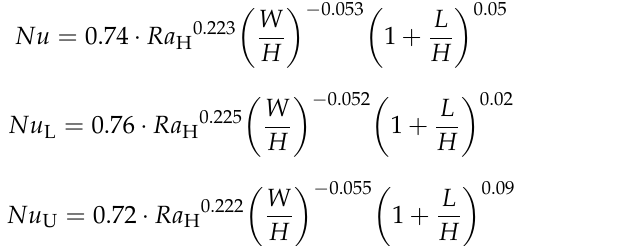
Figure 14. Comparison between Equation (9) and the numerical data obtained for Nu opt . In addition, a set of heat transfer dimensionless correlations is developed for predicting the average Nusselt numbers for the whole system and for each plate and for separation distances between the plates in the range between ( W / H ) opt < W / H ≤ 1: